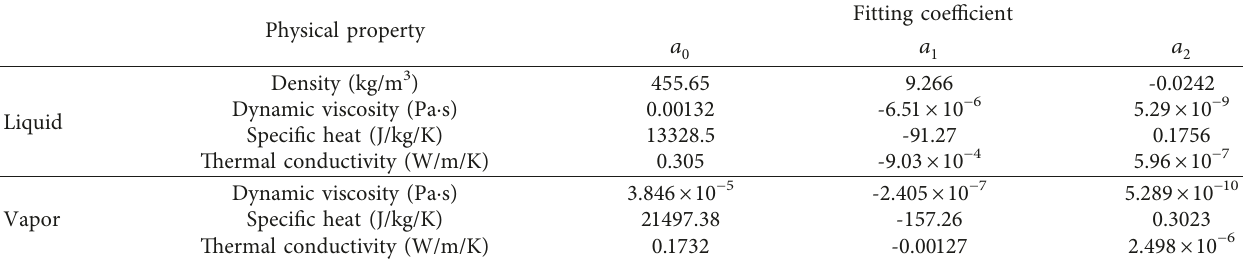
Table 2: Fitting of the variable physical